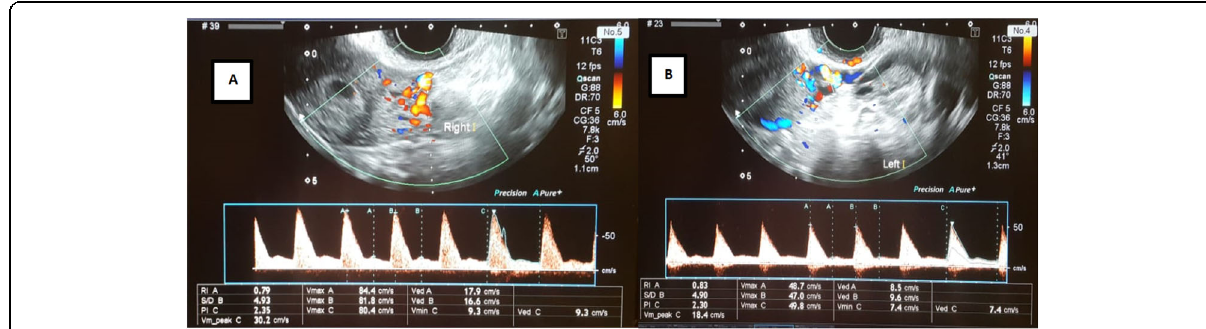
Fig. 8 a , b Transvaginal Doppler ultrasound of both uterine arteries ( a right, b left) of female patient aged 33 years old diagnosed with unexplained infertility shows RI of right and left uterine arteries were 0.79 and 0.83 respectively with mean RI 0.81, S/D ratios of right and left uterine arteries were 4.93 and 4.9 respectively with mean S/D ratio 4.91, and PI of right and left uterine arteries were 2.35 and 2.3 respectively with mean PI 2.32